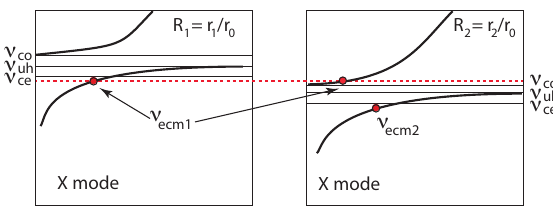
Figure 7. Illustration of the requirements for escape of ECMI ra- diation excited in the X mode to free space if the radiation is gen- erated a frequency beneath the electron cyclotron frequency of the guide field and moves from R 1 → R 2 with r 0 distance of normal- ization. Excitation is on the left at a frequency shown as the red dot. It occurs on the lower branch of the X mode. In a magnetic guide field of spatially decreasing strength (e.g. a dipole field) from location r 1 < r 2 to r 2 , the cut-off (index co), upper hybrid (uh) and cyclotron frequencies (ce) drop below the emission frequency ν emc1 at r 1 . If the wave is able to tunnel the gap on the way to the new lo- cation, its frequency ν emci1 will be found on the free-space branch of the X mode and can escape. Tunnelling is non-trivial. It implies a rather severe condition on the radiated wavelength, angle and den- sity gradient. At r 2 > r 1 emission is at the low indicated frequency ν emc2 < ν emc1 and is trapped in the plasma. An outmoving source will emit downmoving tones. No upmoving tones are seen remotely. They are inhibited by the condition of escape but can occur inside the